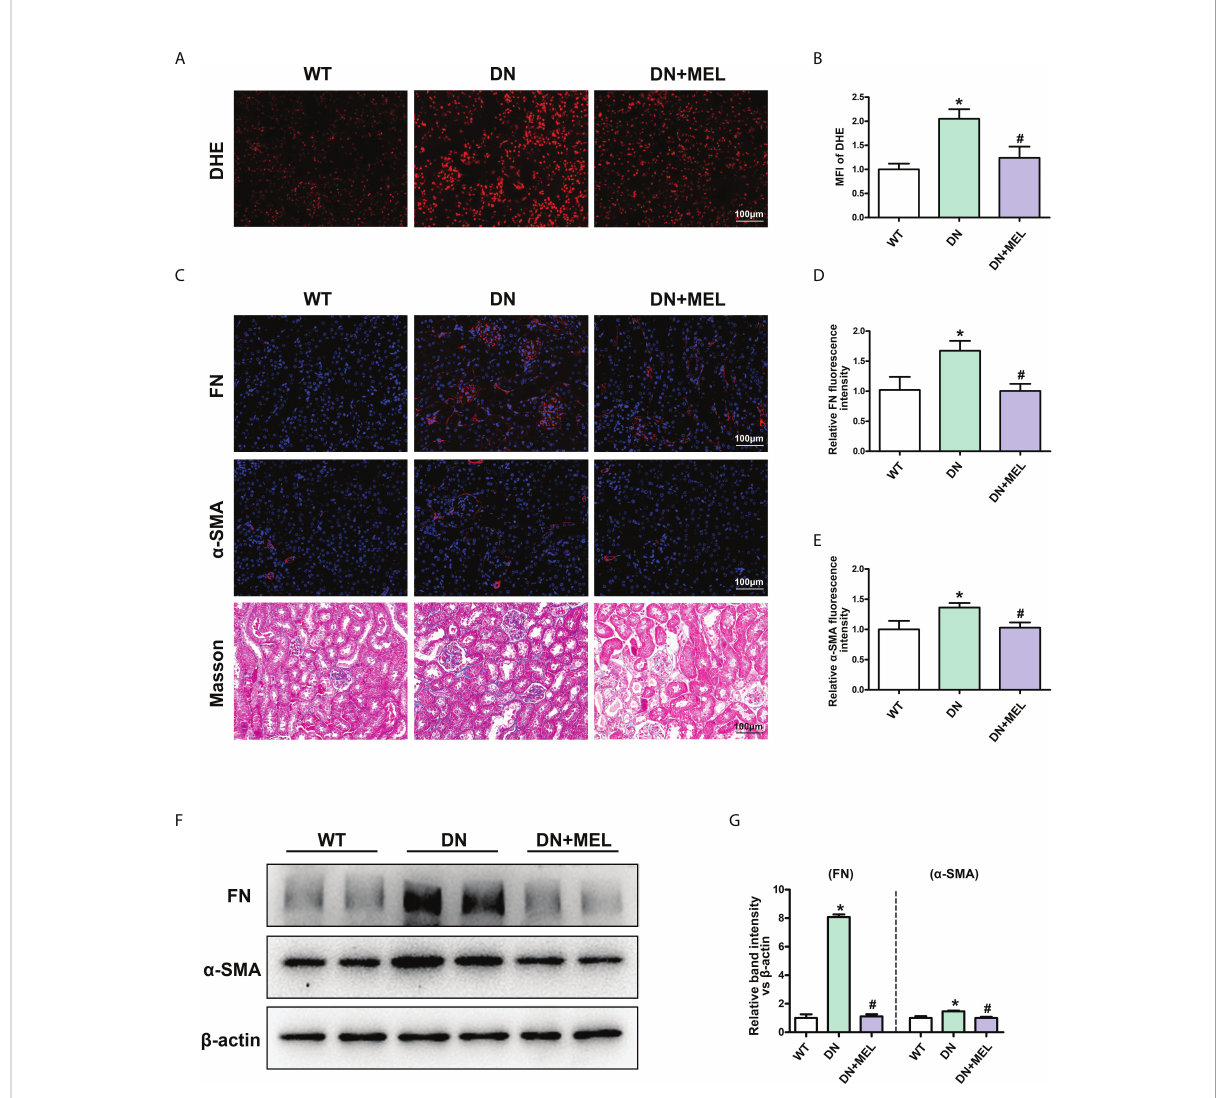
FIGURE 2 The effects of melatonin on oxidative stress and fi brosis in the kidneys of DN mice. DHE staining in the kidneys of different groups (A, B) . IHF analysis of FN (upper panel) (C, D) and a -SMA (middle panel) (C. E) in the kidneys of different groups. Masson staining of renal paraf fi n tissue in different groups ( C , lower panel). Western blot analysis revealed the expression of FN and a -SMA (F, G) . The values are the mean ± SD. n = 6/ group. *p < 0.05 compared with the control group; # p < 0.05 compared with the DN